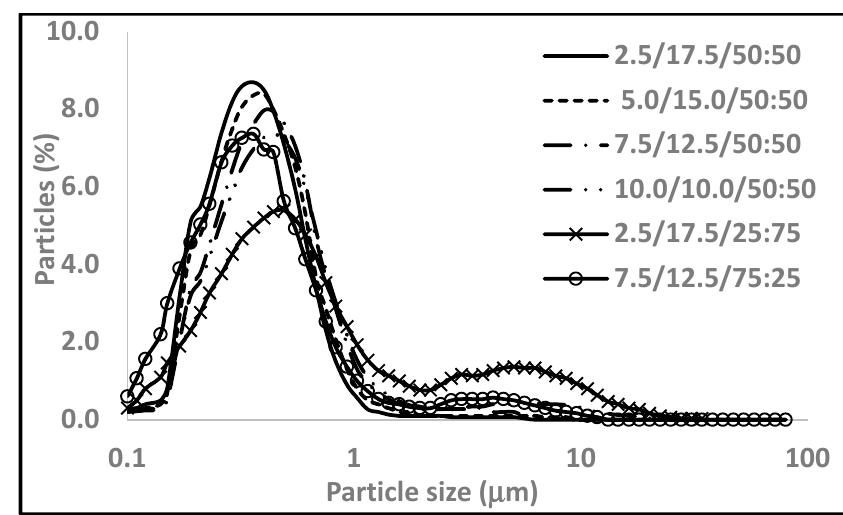
Figure 1. Representative particles size distribution (PSD) of core-in-wall-emulsions (CIWEs).